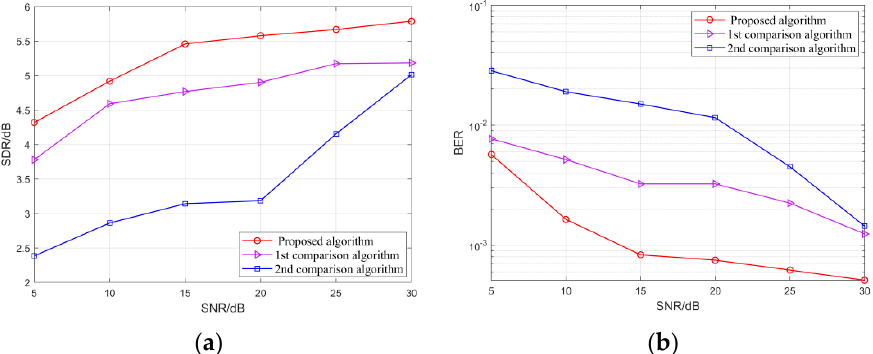
Figure 15. ( a ) The SDR of three BPSK signals under different SNR; ( b ) The BER of three BPSK signals under different SNR. The 1st and 2nd comparison algorithms are given in literature 8 and 10, respectively.